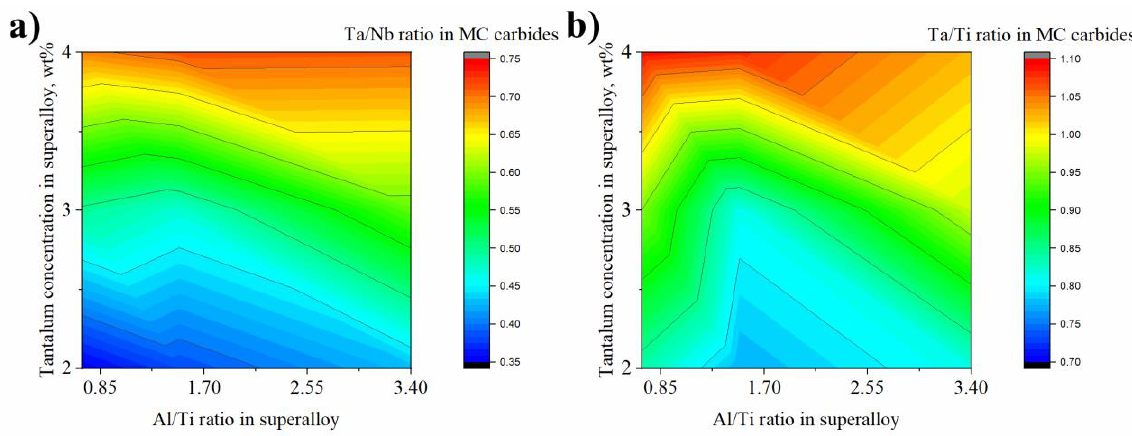
Figure 8. The concentration relationship in the MC carbides: ( a ) Ta/Nb; ( b ) Ta/Ti, calculated based on the semi-quantitative SEM-EDX measurements.